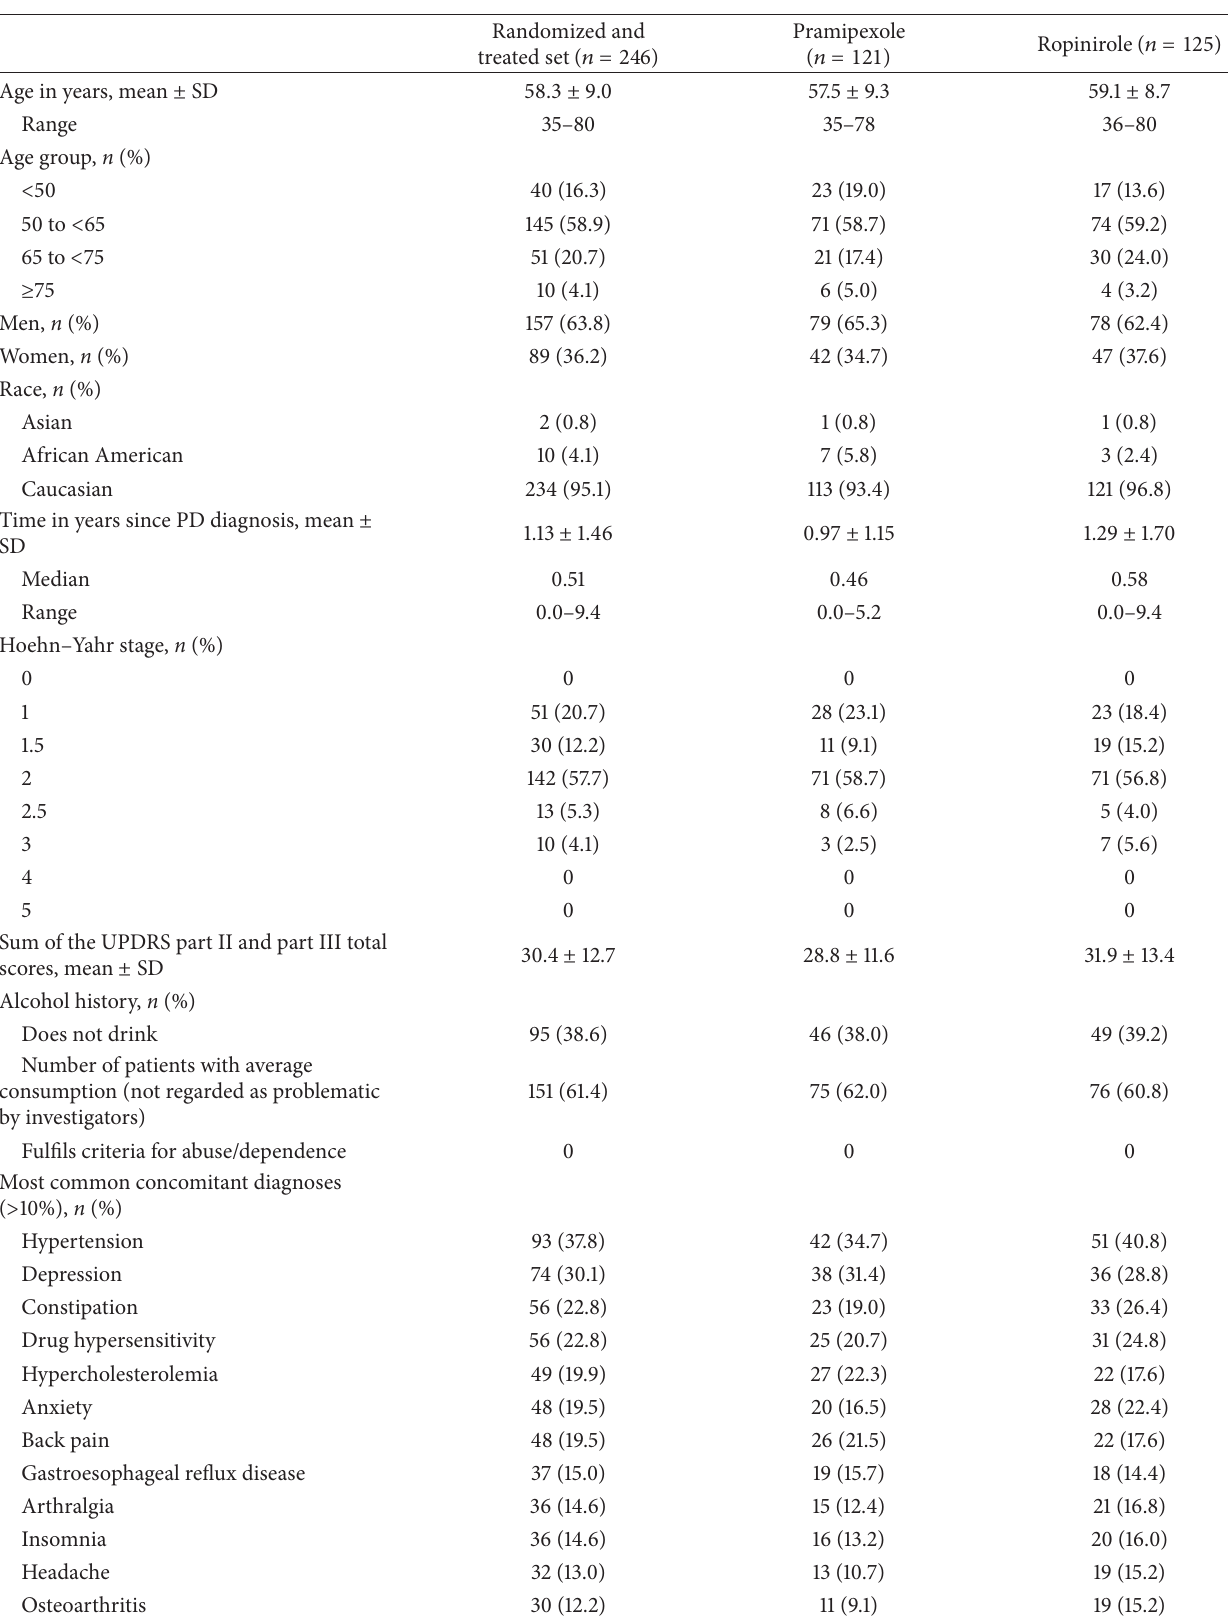
Table 1: Demographic baseline characteristics of the 246 randomized and treated subjects who had ophthalmologic